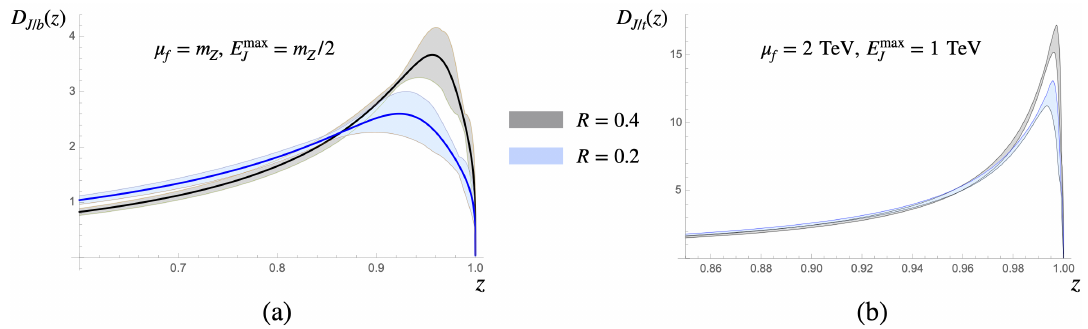
Figure 4 . Uncertainties (gray bands) arising from choosing the jet scales between B (the upper bound) and B (1 − z ) (the lower bound) in (a) the b quark FFJ and (b) the top quark FFJ when we employ the naive DGLAP evolution in eq. (3.38). The solid lines denote the properly resummed results following eq. (3.34) based on the factorization shown in eq. (2.29).